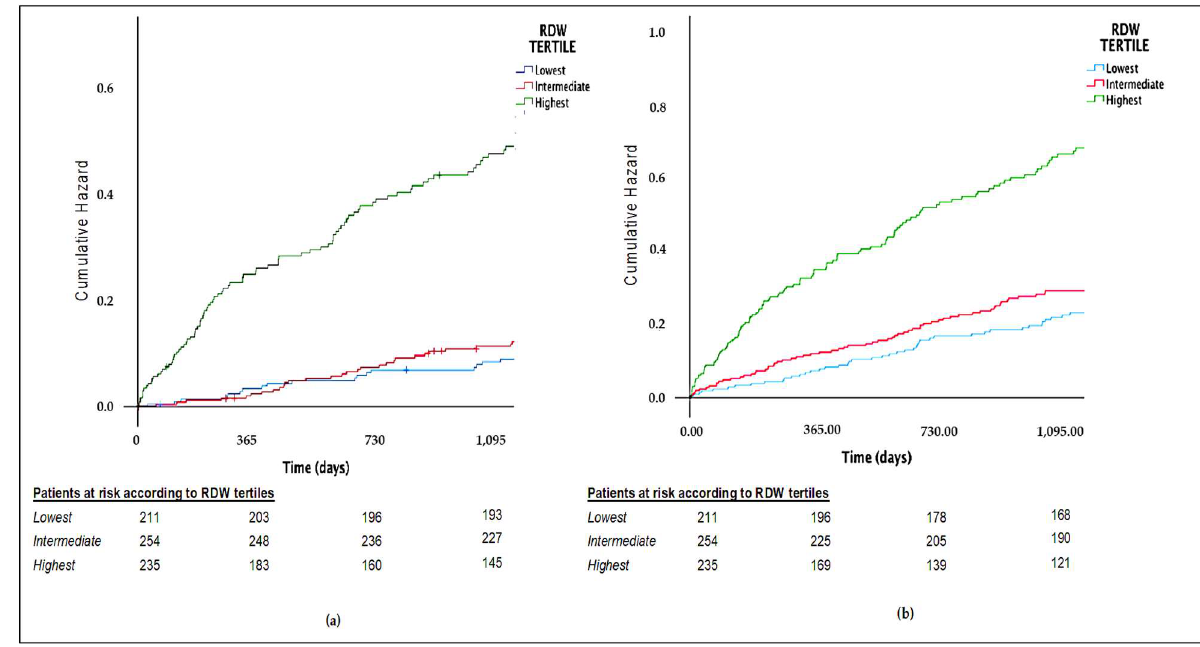
Figure 1. ( a ) Cumulative hazard for all-cause death. ( b ) Cumulative hazard for the composite endpoint. With the multivariable Cox regression analysis (Tables 3 and 4), after multiple adjust- ments, the highest RDW tertile was independently associated with an increased risk of